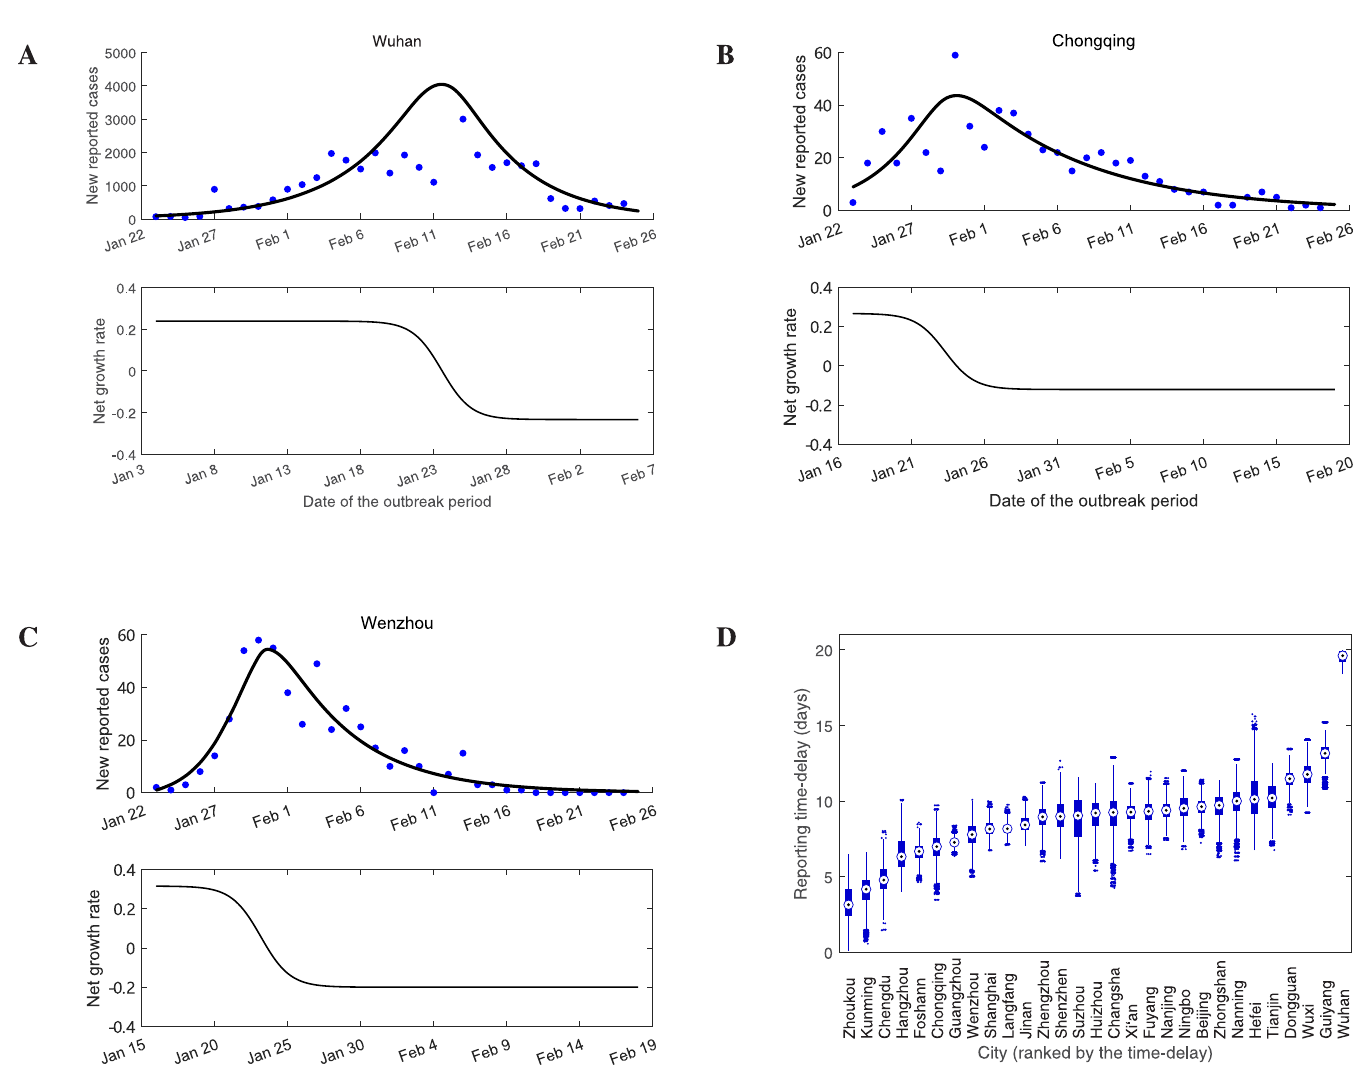
Fig 3. The net growth rates and reporting time delays. A-C : The fitted results and the estimated net growth rates (black curves) in three cities with the highest peaks of prevalence in the selected 29 cities. The solid blue dots are real data and one outlier in Wuhan is not shown in the figure. There were different lags between the estimated net growth rates and the numbers of reported cases in each city. D : The estimated reporting time delays in all 29 cities. These reporting time delays are region specific.